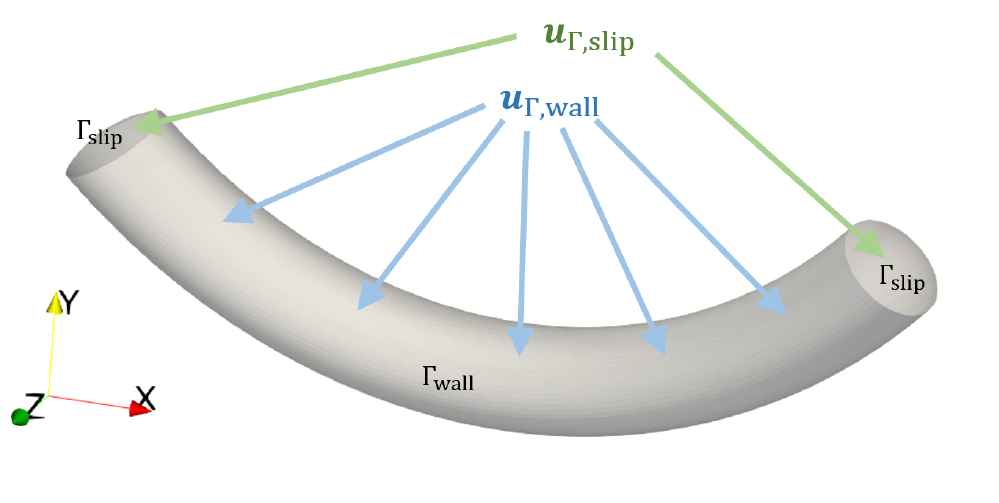
Figure 4. Geometrical representation of the liquid slug with the respective boundary conditions. The simulations in case of low rotational speeds reach fully stationary flow